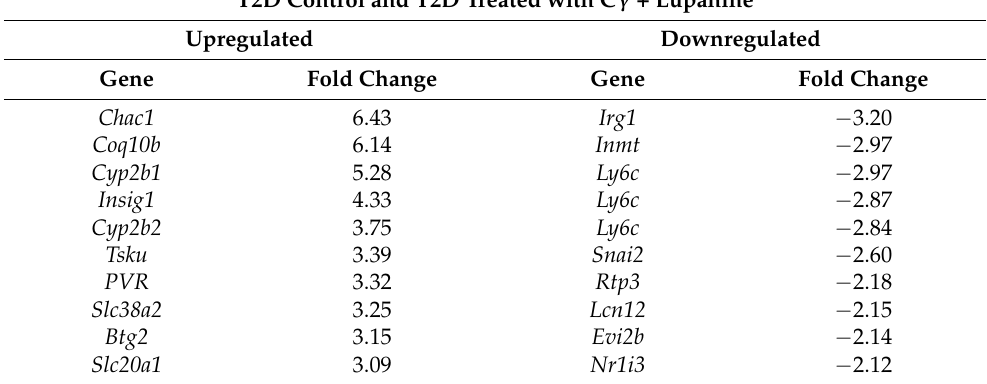
Tsku Table 2. Top 10 differentially regulated coding genes. PVR 3.32 Rtp3 T2D Control and T2D Treated with C γ + Lupanine Slc38a2 Upregulated Gene Fold Change T2D: type 2 diabetes, C γ : gamma